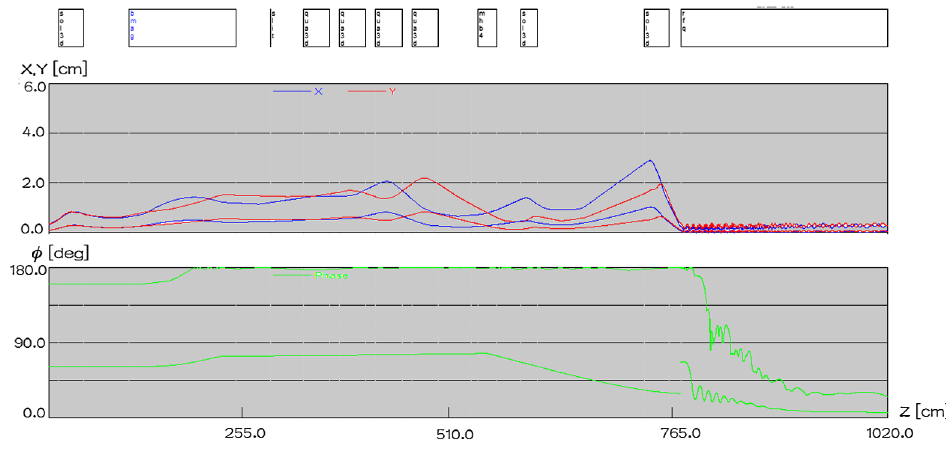
FIG. 6. The evolution of the beam envelope throughout the SSC-Linac front-end